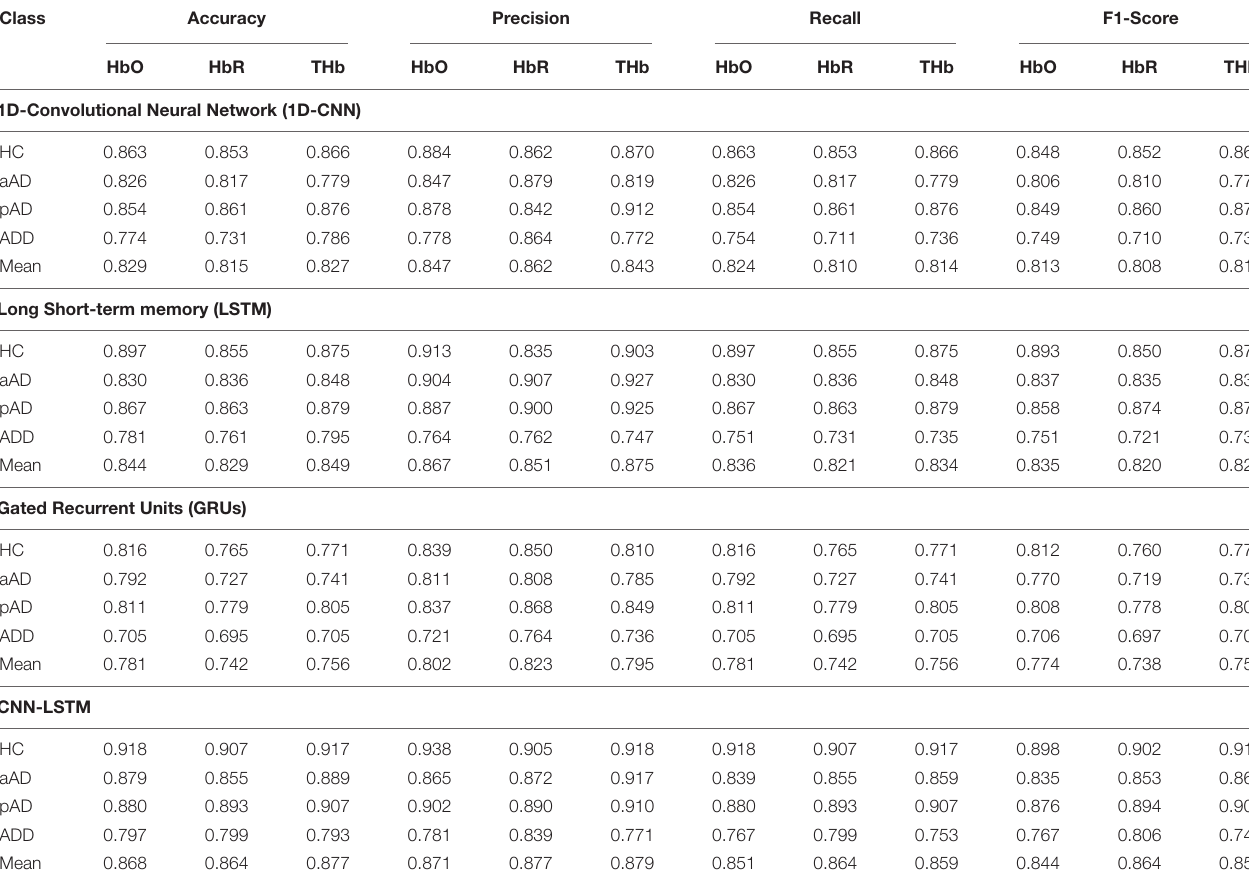
TABLE 2 | Comparison of classification metric results as shown by four proposed deep learning (DL) models using original data. Class Accuracy Precision Recall